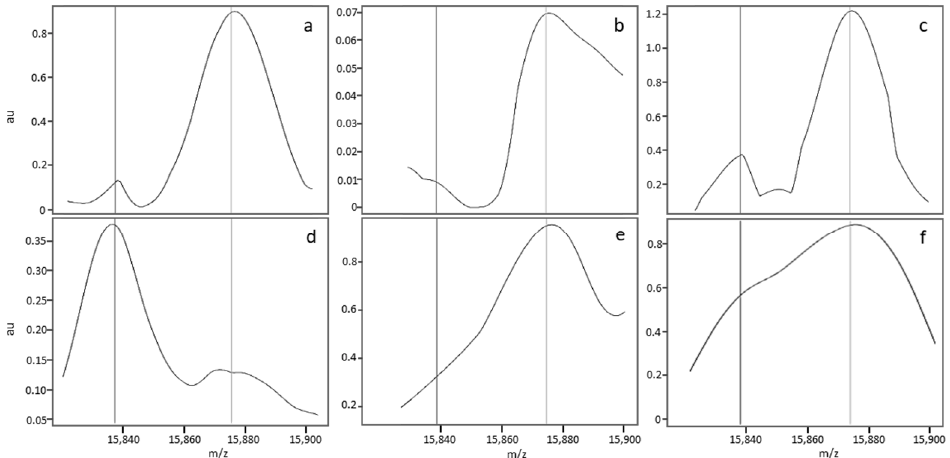
Figure 3. Zoom of MS profiles on the zone of interest for nonstandard FA ( a , b , e ), FAS ( c , f ) and FS ( d ) samples.